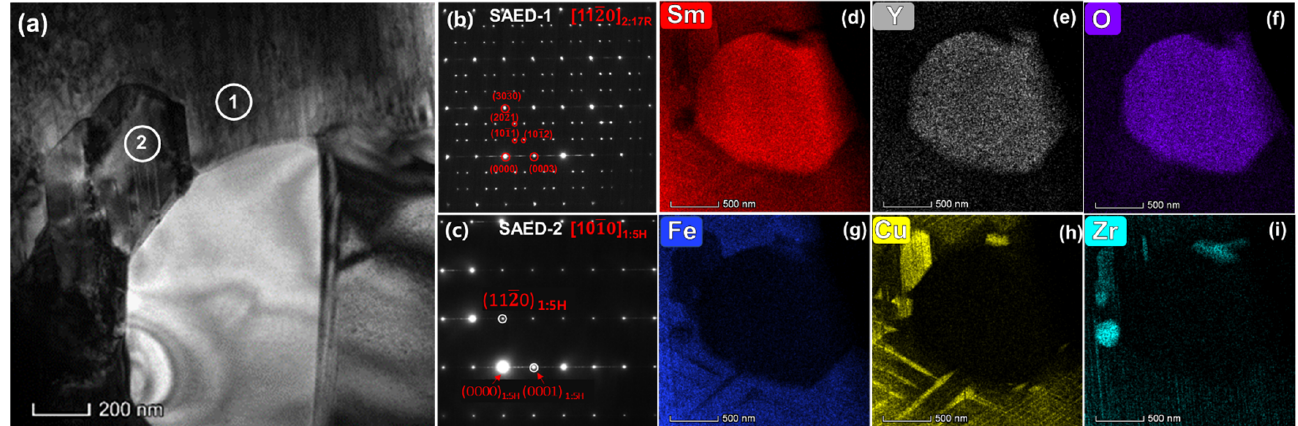
Figure 5. The TEM bright field image of cellular structure with the Y-Sm oxide inserted parallel to the c-axis ( a ) and its elements mapping ( d – i ), the selected area electron diffraction (SAED) of 2:17R cell phase ( b ) and the Cu-rich impurity phase ( c ).